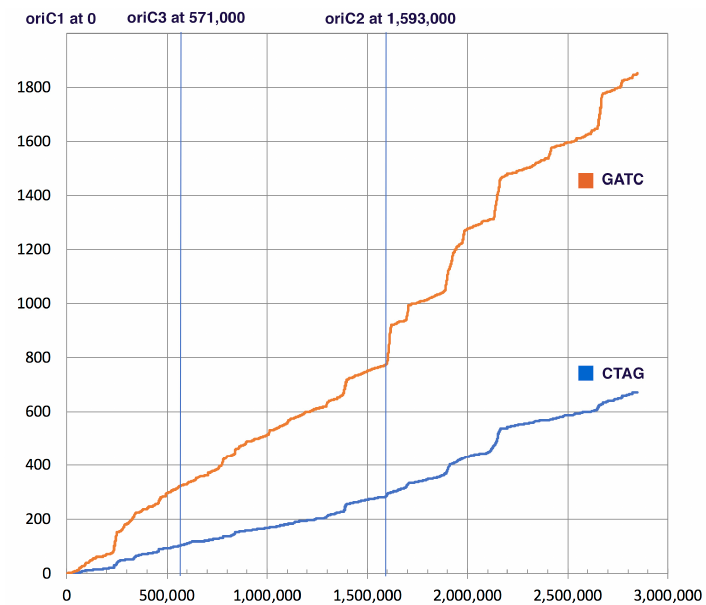
Figure 3. Cumulative occurrence (y-axis) of GATC (orange) and CTAG (blue) motifs along the Haloferax volcanii DS2 genome (x-axis). The location of the origins of replication identified in Hawkins et al. [54] are indicated on top.